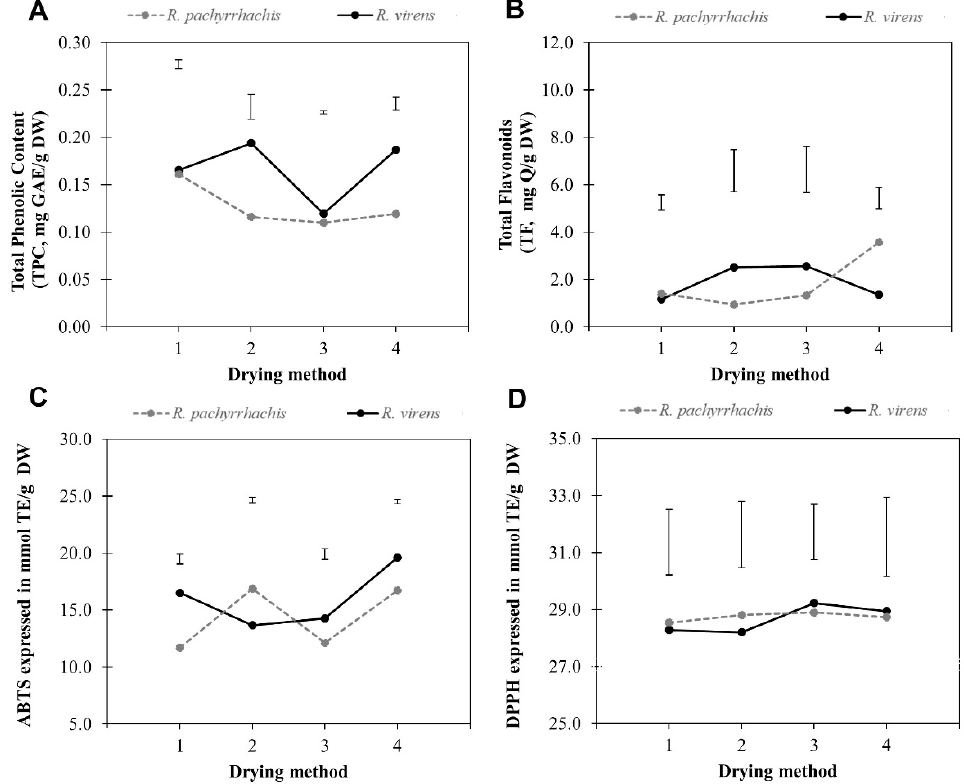
Figure 1. Marginal means of total phenolic content (TPC) ( A ), total flavonoid (TF) ( B ), and free radical-scavenging capacity against 2,2 ′ -azino-bis(3-ethylbenzothiazoline-6-sulfonic acid) (ABTS) ( C ) and 2,2-diphenyl-1-picrylhydrazyl DPPH ( D ) radicals of Rhus pachyrrhachis and Rhus virens . Vertical bars represent the Tukey’s honest significant difference (HSD, p ≤ 0.05) appropriated to compare the species in the same drying method. Table 1. Global aggregated results of TPC, TF, and free radical-scavenging capacity against ABTS and DPPH radicals of Rhus pachyrrhachis and Rhus virens .